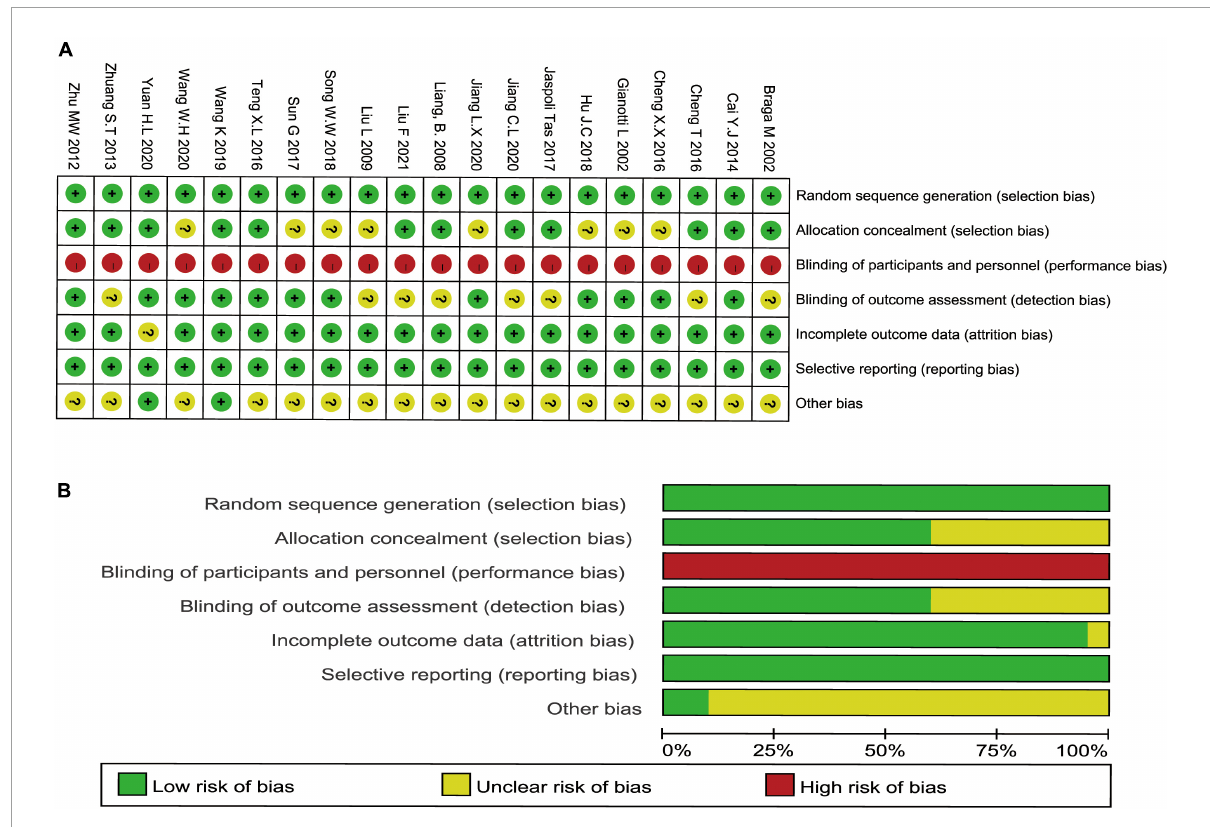
FIGURE2 Methodological quality graph and summary of the included studies: (A) schematic diagram of the literature methodology quality assessment and (B) the ratio of literature methodology quality assessment.